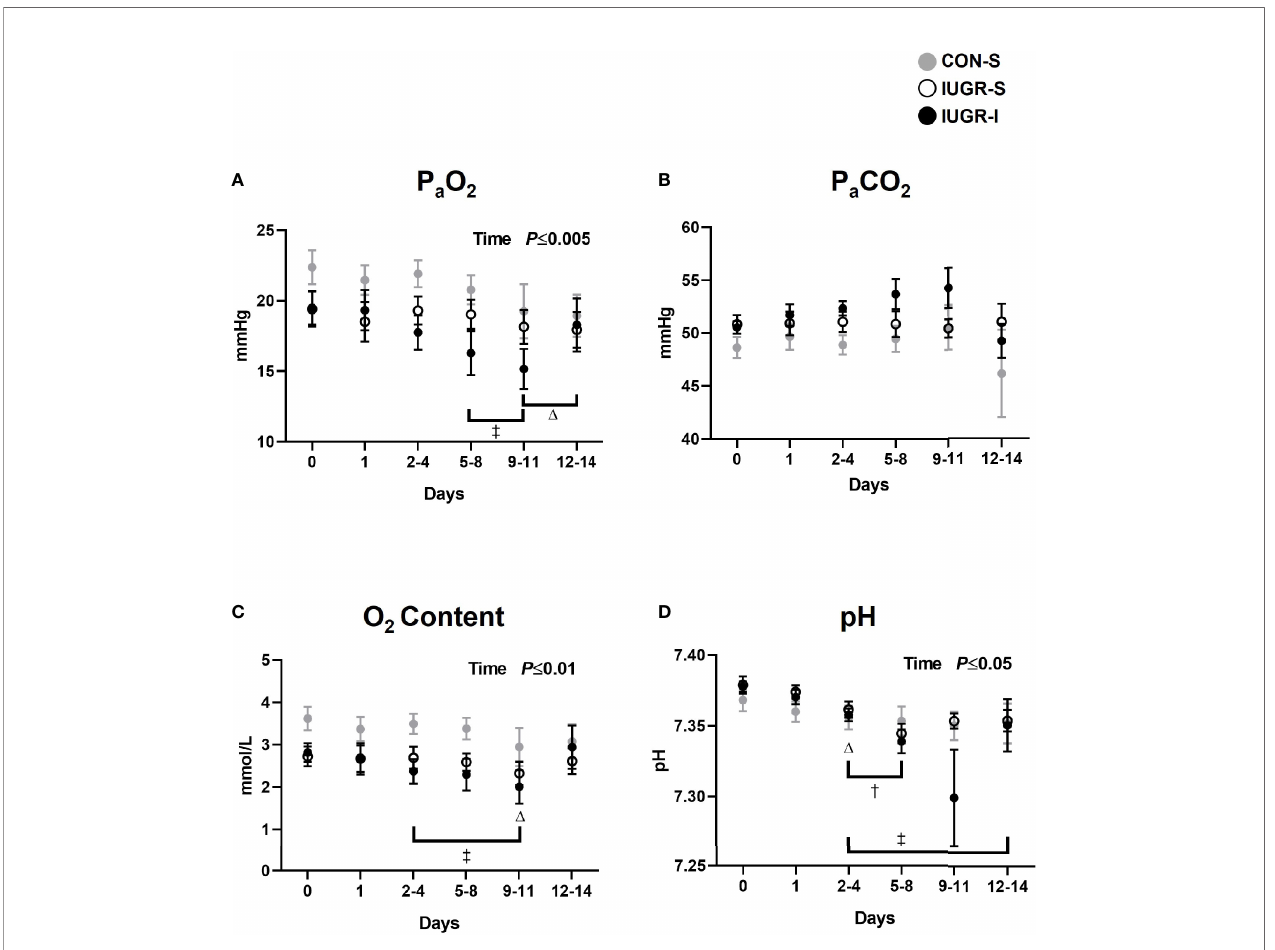
FIGURE 2 | Fetal arterial blood gases. Fetal arterial (A) P a O 2 , (B) P a CO 2 , (C) O 2 content, and (D) pH during insulin or saline infusion period. CON-S (grey circle, n=6), IUGR-S (white circle, n=7), and IUGR-I (black circle, n=11). Values are mean ± SEM. Statistical signi fi cance was designated at P ≤ 0.05 by two-way ANOVA to determine the effects of treatment (CON-S, IUGR-S, IUGR-I), time (day of infusion), and interaction. Fisher ’ s least signi fi cant difference post hoc test was indicated by the following: D , CON-S vs . baseline; † , IUGR-S vs . baseline; and ‡ , IUGR-I vs .